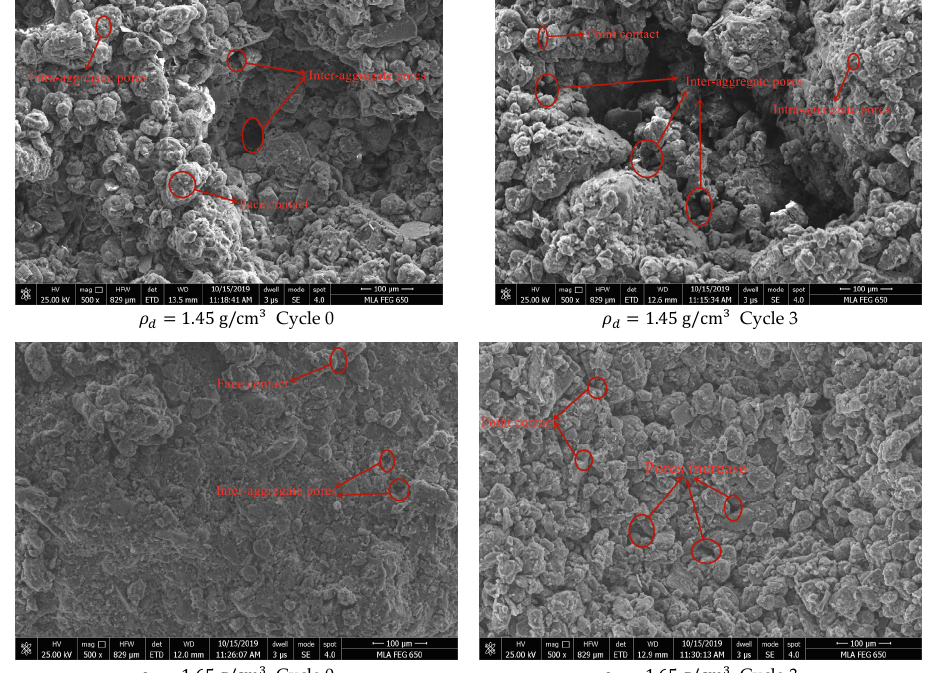
Figure 5. SEM photos of compacted loess Figure5. SEM photos of compacted loess samples The pore type of the 1.45 g/cm 3 dry density samples did not change significantly after the drying-wetting cycles, but the proportion of inter-aggregate pores in the overall mi- crostructure increased, indicating that the drying-wetting cycles would destroy the struc- tural integrity of the compacted loess, while other indicators of microstructure changed little. That is to say, the change in the overall microstructure of this density is the least among the three dry density samples, which was consistent with the finding that the suc- tion stress of the 1.45 g/cm 3 dry density loess sample decreased after drying-wetting cy- cles, but the amplitude was small (Figure 4b). For the loess samples with a dry density of 1.65 g/cm 3 , the samples had a large size differential, and consisted of large and small aggregates before the drying-wetting cycles. The aggregates were mainly bonded together in the form of face contact with poor pore connectivity. However, after the drying-wetting cycles, the aggregate size of the sample decreased and was more uniform. The contact form between aggregates changed to point contact with more apparent aggregate contours and greater apparent porosity. The change in aggregate contact form indicated that water dissolved cement during the dry- ing-wetting cycles, causing some small and medium-sized pores to develop into macropores [46], increasing the soil porosity ratio and the volume of macropores. At the same time, due to irreversible van der Waals forces, the size of soil aggregates increased after the wetting-drying cycle, which made clay closer to the aggregates, and created larger aggregates [47]. The increase in aggregates means that the specific surface area de- creased. In general, the drying-wetting cycles changed the structural characteristics and pore size of the samples. After the drying-wetting cycles, a large discontinuous pore space was formed inside the compacted loess sample. On the one hand, air entered the larger pores